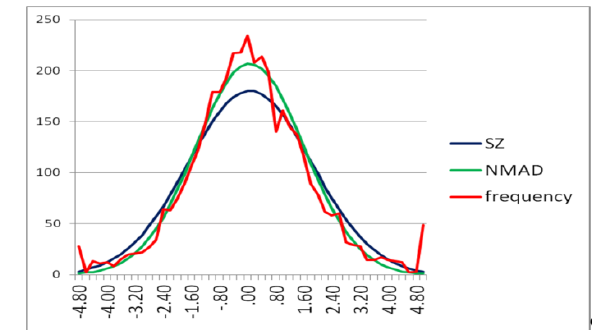
Figure 14. Frequency distribution of differences in height between DTMs of all images and the reference